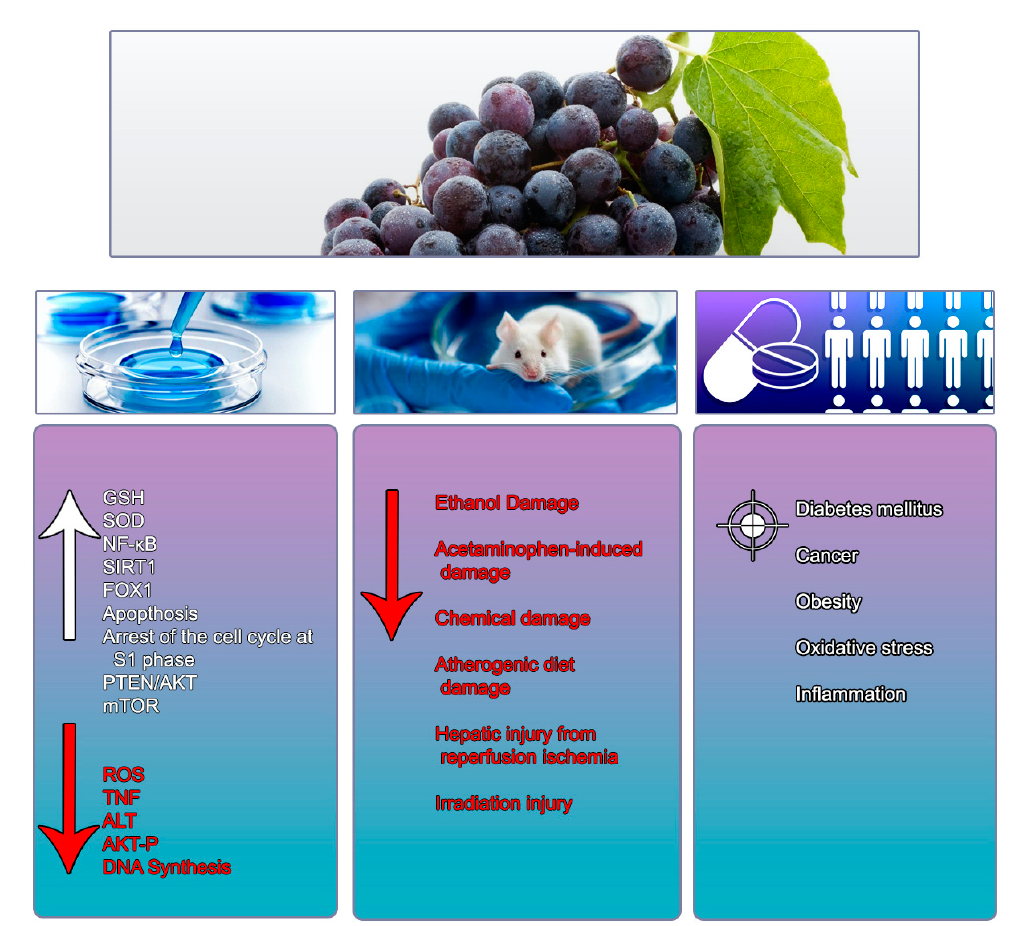
AMPK: AMP activated protein kinase, Ang-2: angiopoietin, FBS: fasting blood sugar, Flk-1: fetal liver kinase-1, HbA1c: glycosylated hemoglobin, IGF: insulin-like growth factor, IGFBP-3: insulin-like growth factor binding protin-3, MCP-1:monocyte chemoattractant protein-1, NAFLD: Non-alcoholic fatty liver disease, NF- κ B: nuclear factor kappa light chain enhancer of activated B cells, RSV: resveratrol, SIRT1: sirtuin 1, T1D: type 1 diabetes, T2D: type 2 diabetes, TNF- α : tumor necrosis factor- α , UF: ultrafiltration, VEGFR: vascular endothelial growth factor receptor.